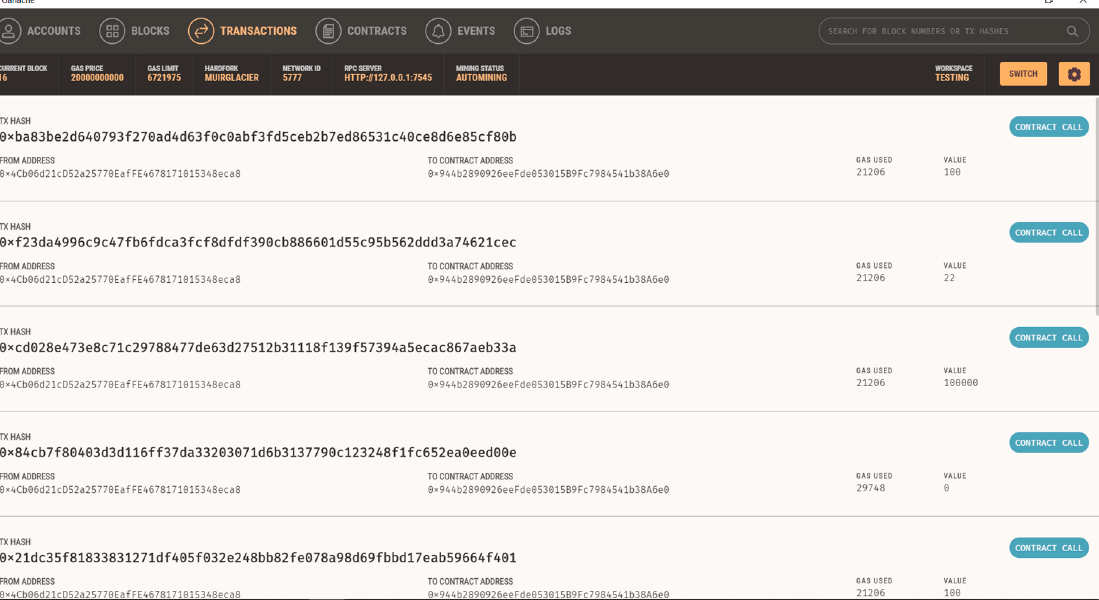
Figure 8. Details of block 16 on the Blockchain server.